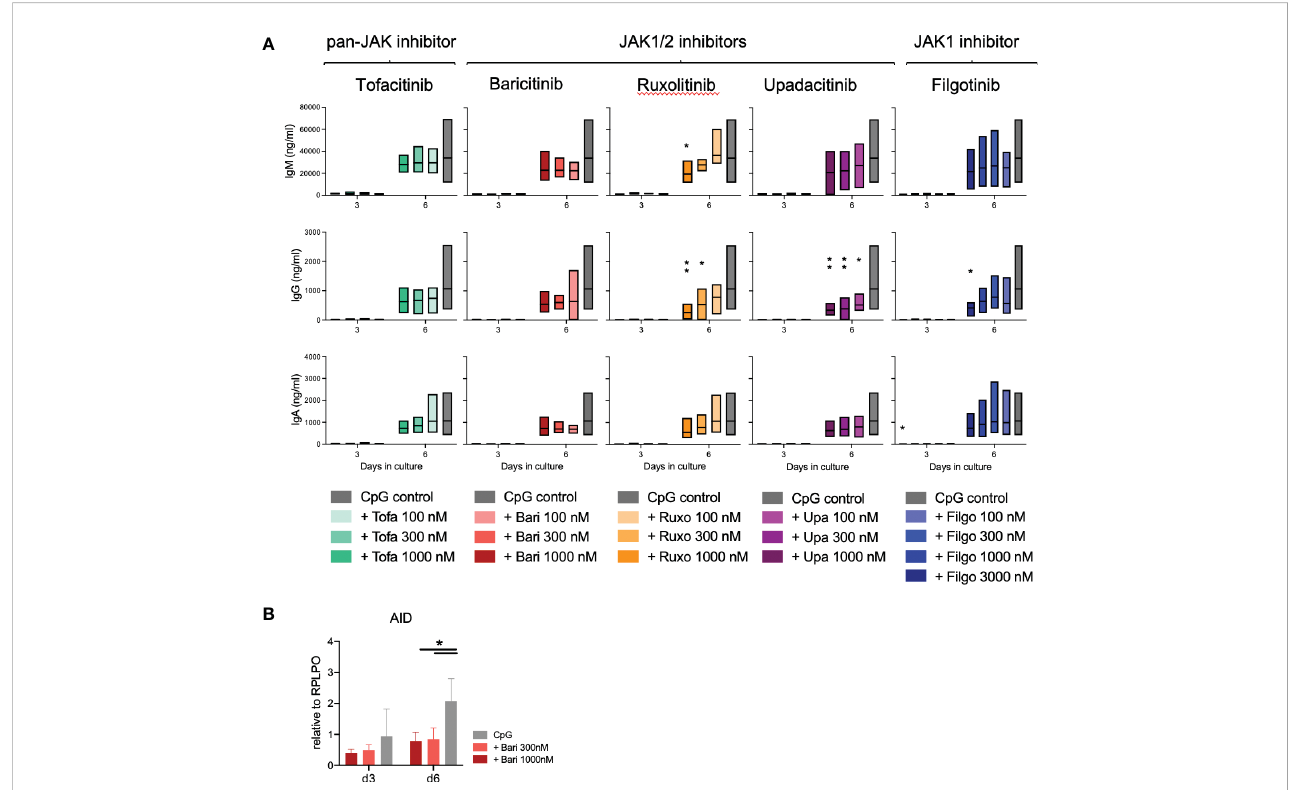
FIGURE 3 Immunoglobulin secretion and class switch under JAK inhibition. (A) : Immunoglobulins measured by ELISA in supernatants of 3 experiments with triplicates each. Data depicted as fl oating bars (min to max) with line at mean. ANOVA with Dunnett ’ s multiple comparisons test as follow-up test, *p < 0.05, **p < 0.005. (B) : Expression of the class-switch mediating enzyme AID under JAK inhibition with baricitinib measured by qPCR. Data from 4 experiments depicted relative to B cell housekeeping gene RPLPO. ANOVA with Dunnett ’ s multiple comparisons test, *p <